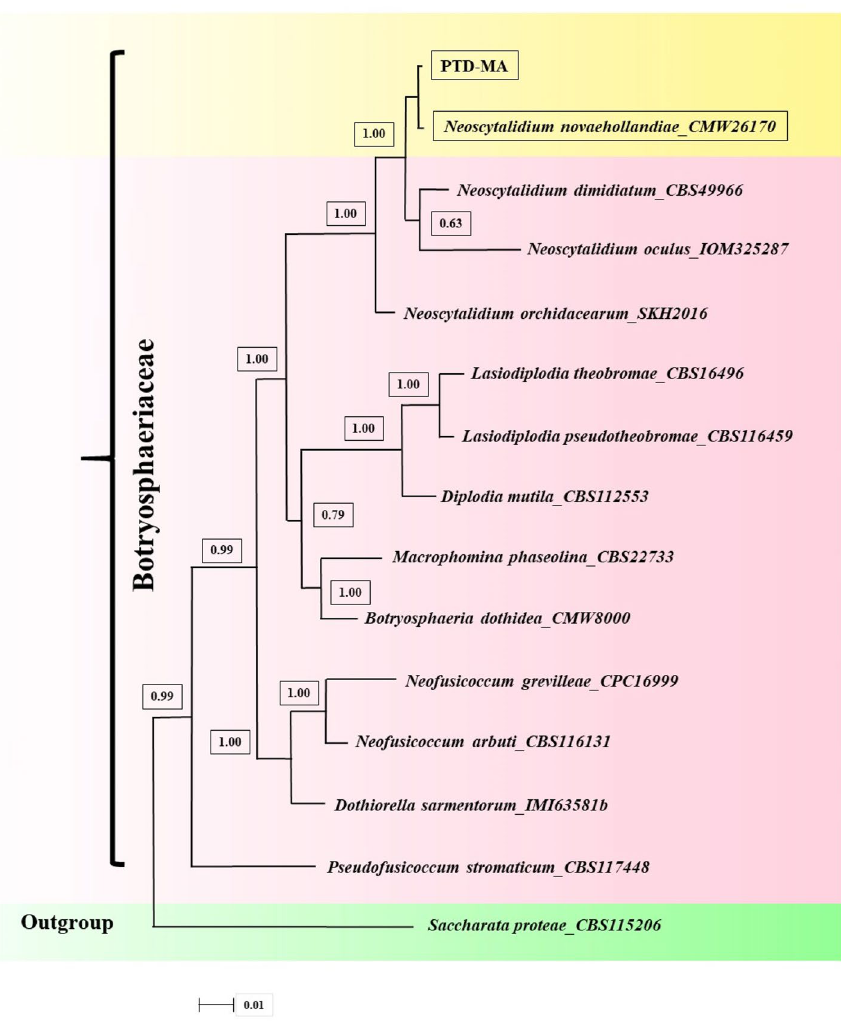
Figure 5. Bayesian tree inferred under the GTR + G model from the combined sequences of ITS, TEF1-α and LSU for Neoscytalidium novaehollandiae and related species of closest genus, using Saccharata proteae as outgroup. The sequences aligned using MAFFT software and edited using Gblocks program. Bayesian posterior probabilities more than 0.50 are given for appropriate clades. Newly obtained sequence and another isolate of N. novaehollandiae indicated by yellow framework. PTD-MA is the isolate of this